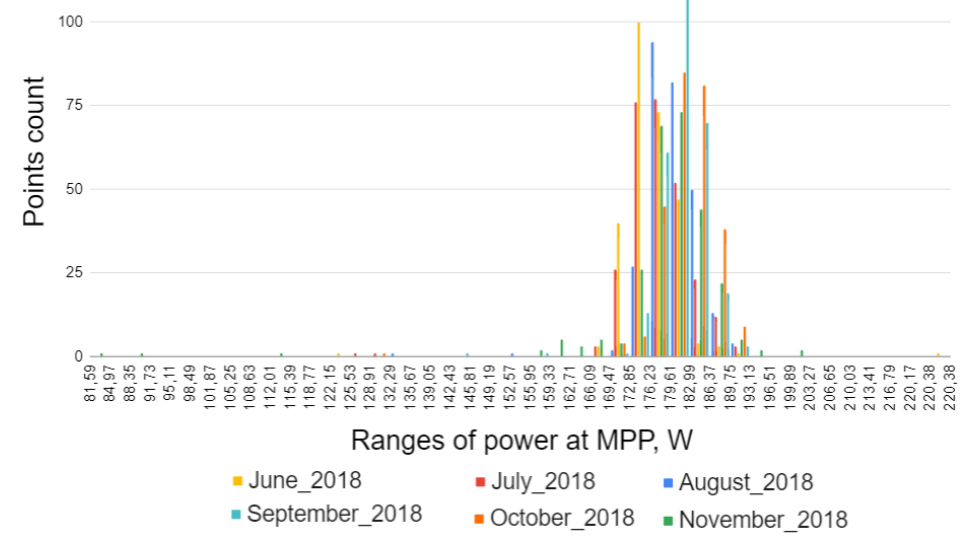
per modules in June – November, mpp